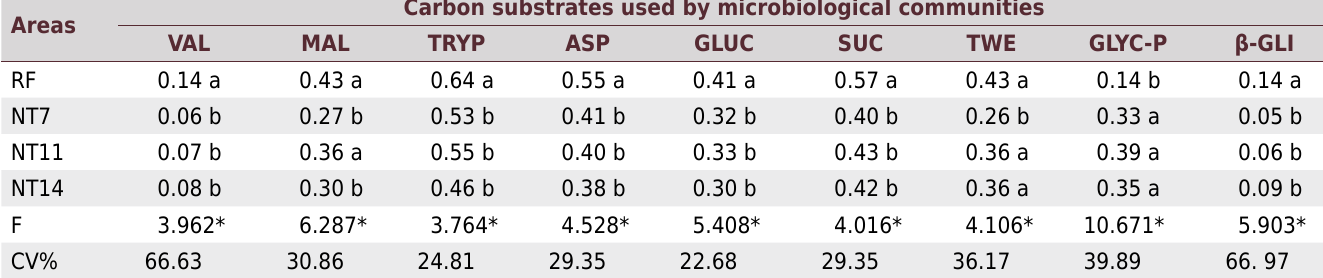
Table 4. Overall rate of color development in different substrates used by the soil microbiological communities from chronosequence areas of no-tillage and murundus field area Carbon substrates used by microbiological communities Areas